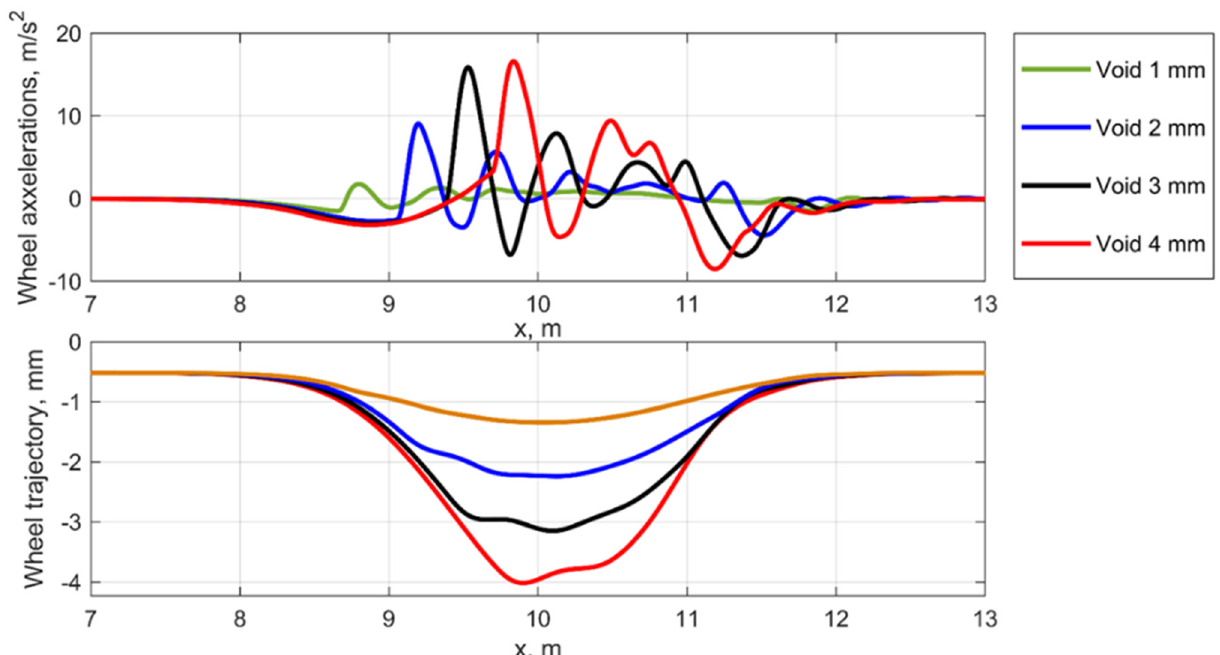
Figure 7. Simulated wheel accelerations and trajectories for the void irregularity.